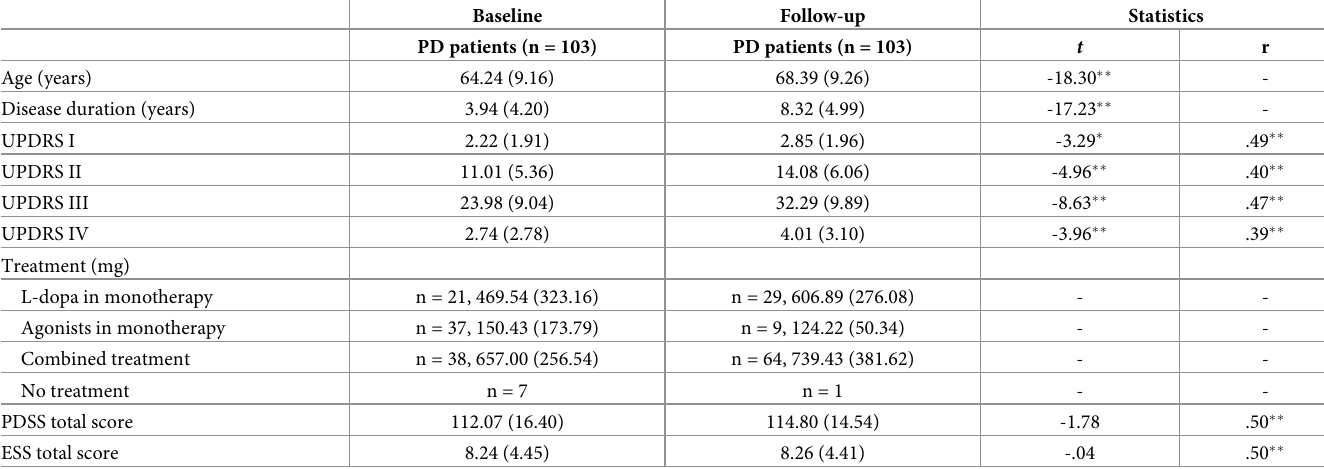
Table 1. Demographical and PD-related clinical